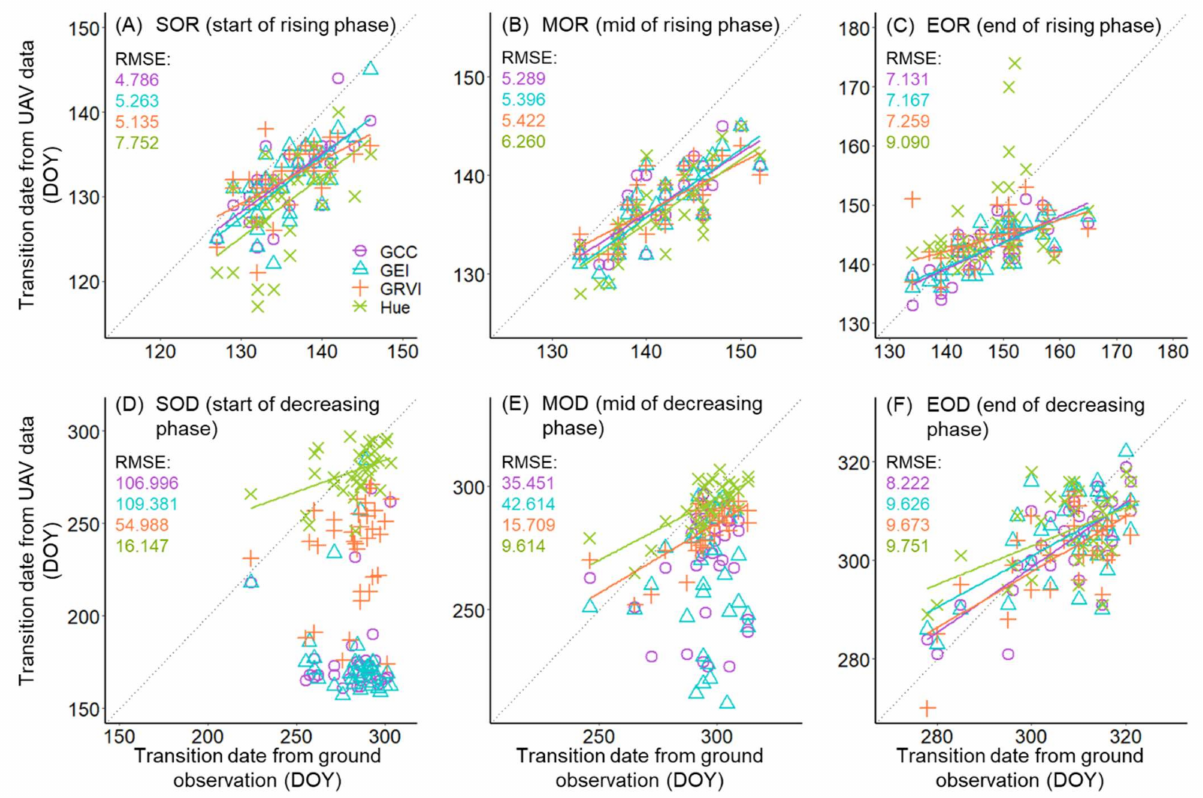
Figure 3. Comparison of leaf phenological transition dates derived from UAV metrics and those derived from crown leaf cover based on ground observations (CLC ground ). Each point represents data for an individual tree. Dotted lines are 1:1 lines, and solid lines are linear regression equations ( p < 0.05) as follows: Panel ( A ) GCC: y = 0.69 x + 38.75, r 2 = 0.53; GEI: y = 0.73 x + 32.16, r 2 = 0.51; GRVI: y = 0.51 x +